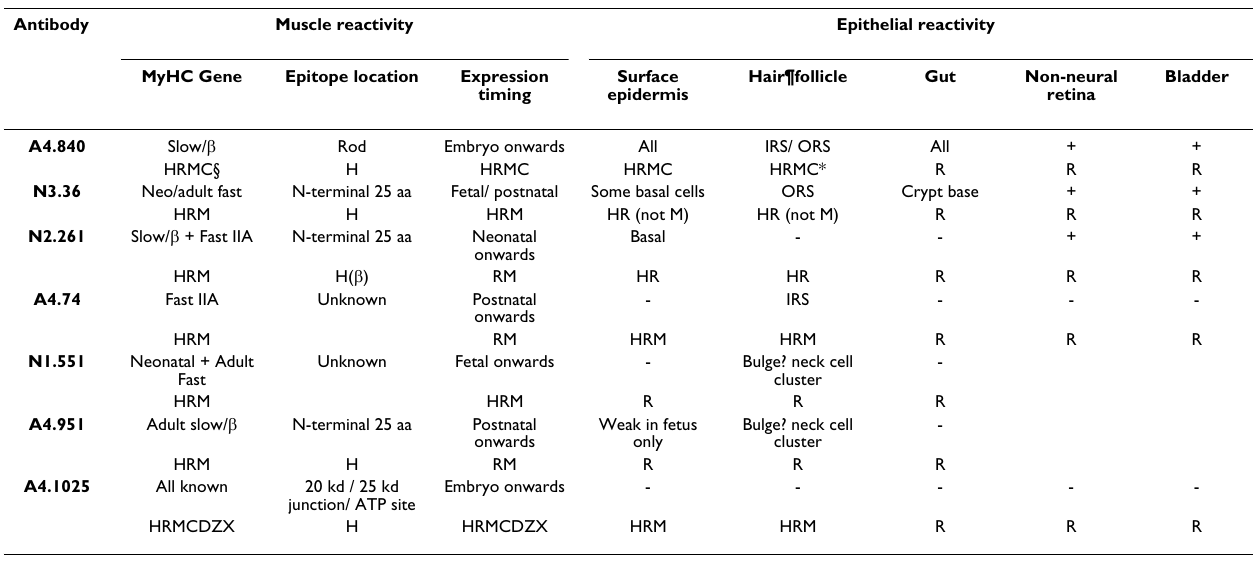
Table 1: Summary of antibodies, their known MyHC epitopes and epithelial reactivity.